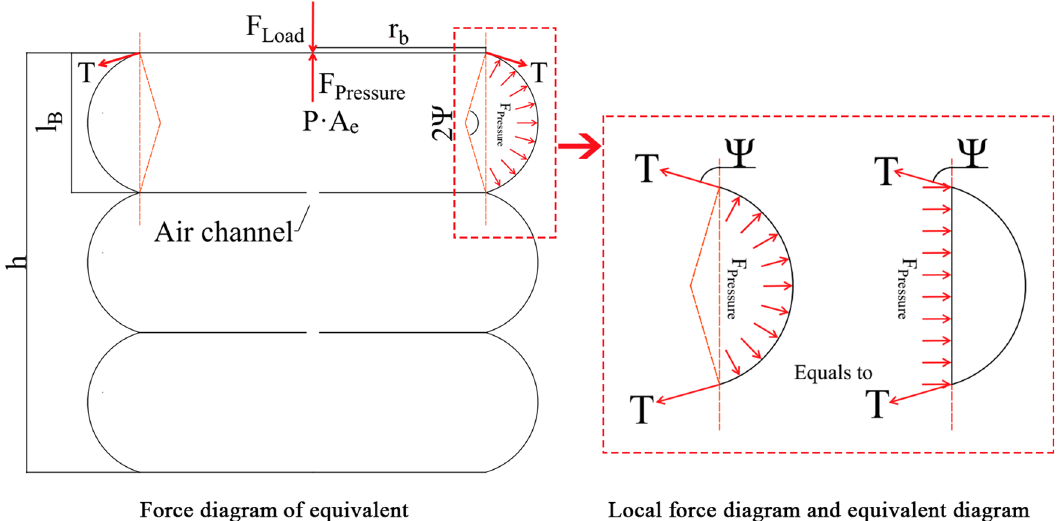
Fig. 9. Diagram of air spring structure